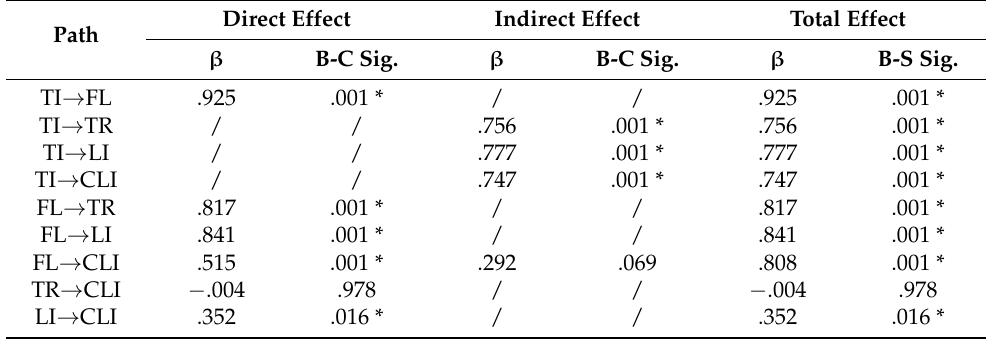
Table 10. Paths affect results.